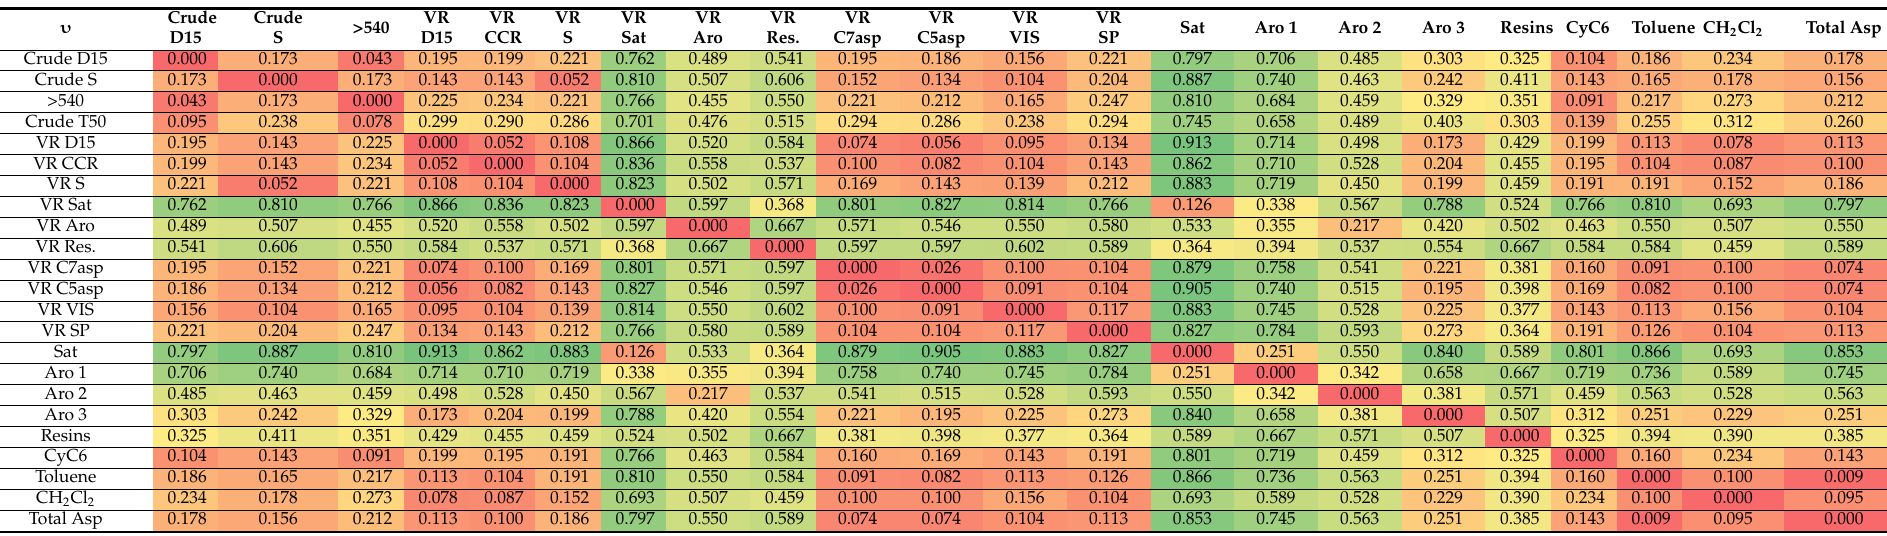
Table 7. υ -Value of the ICrA evaluation of relations between crude oil and vacuum residue bulk properties, LNB SARA, and SAR-AD